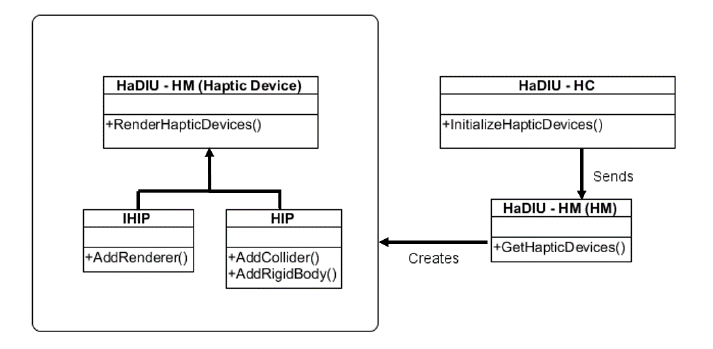
Figure 5. Factory design pattern used during the development of Haptic Device Integration for Unity